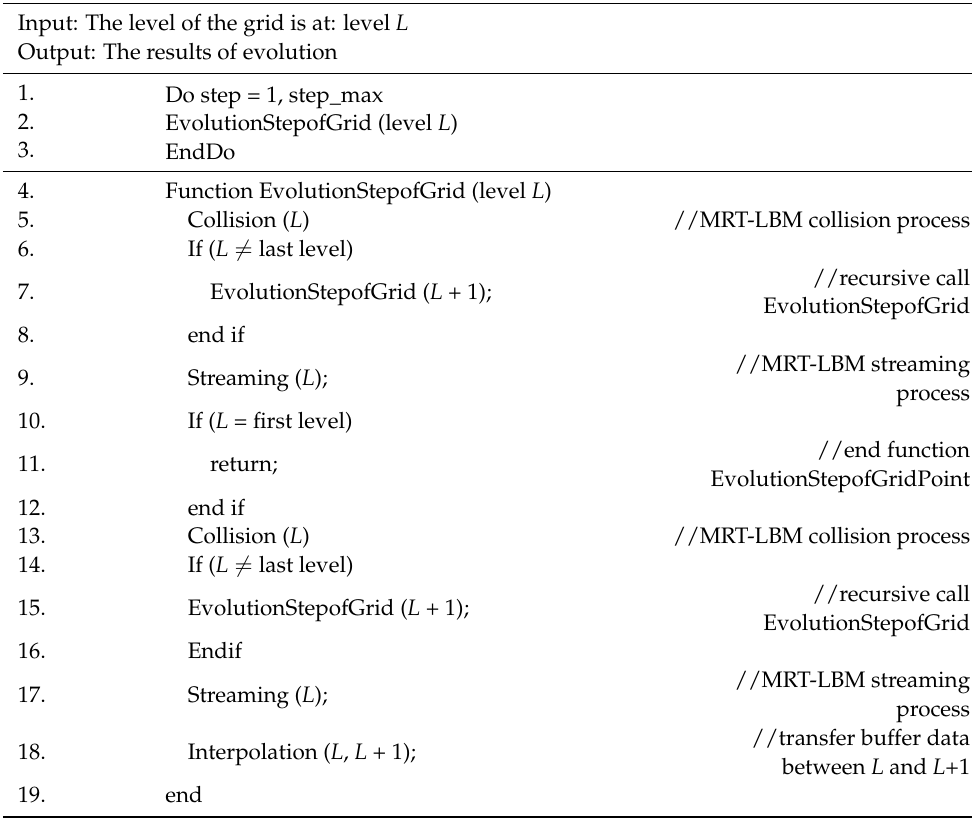
Algorithm 3 Multi-level grid MRT-LBM